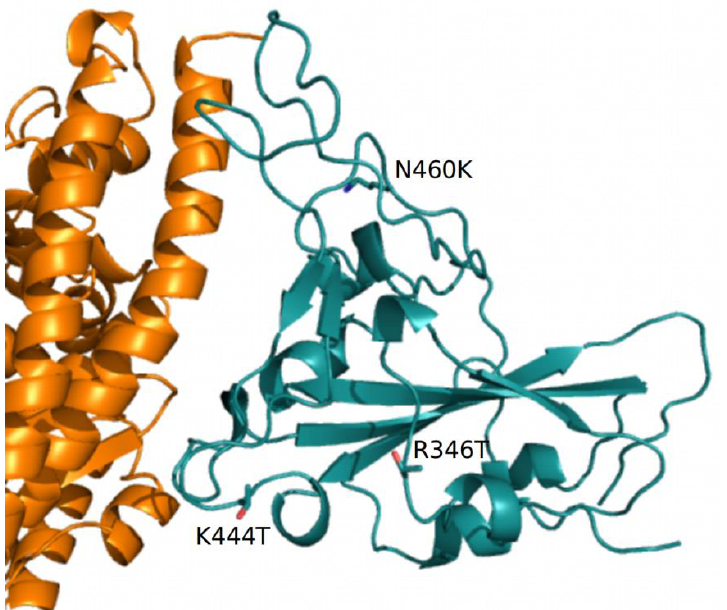
Figure 5. Complex between ACE2 (orange) and RBD (deep teal) represented as cartoon models. The side chains of the residue mutations specific to BQ.1 are displayed with stick models and are labeled. Only part of the ACE2 receptor is displayed.